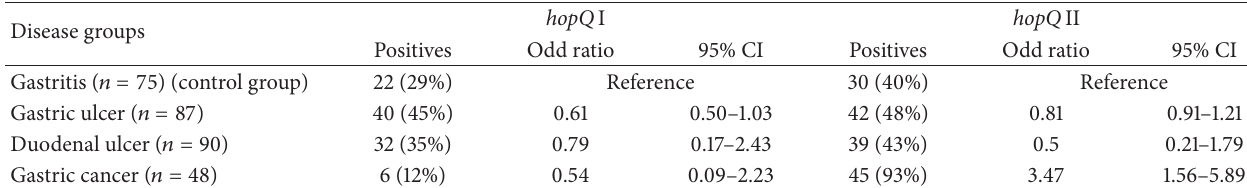
Table 2: Distribution of the hopQ I and hopQ II among the different